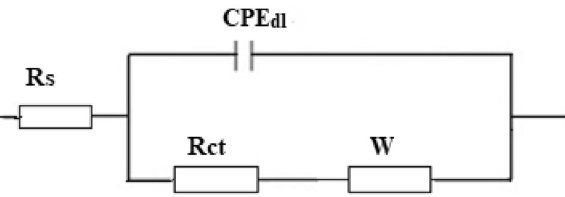
Figure 10. The equivalent circuit